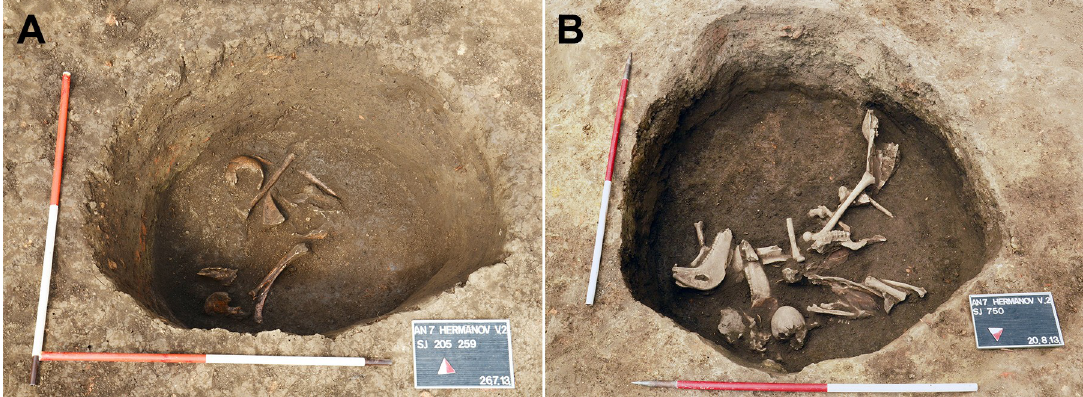
Fig 5. The pit from Osijek—Hermanov vinograd site during the excavation. A) The upper layer containing commingled skeletal remains, mostly human. B) The lower layer with commingled human and animal remains.